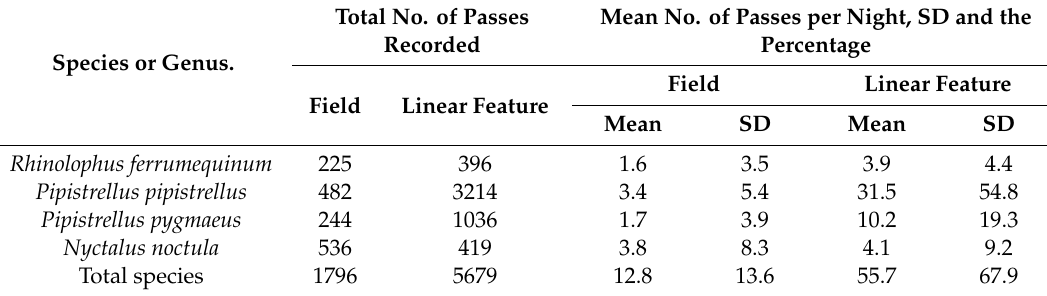
Table 1. Bat species activity recorded along linear features compared to in the middle of agricultural fields.